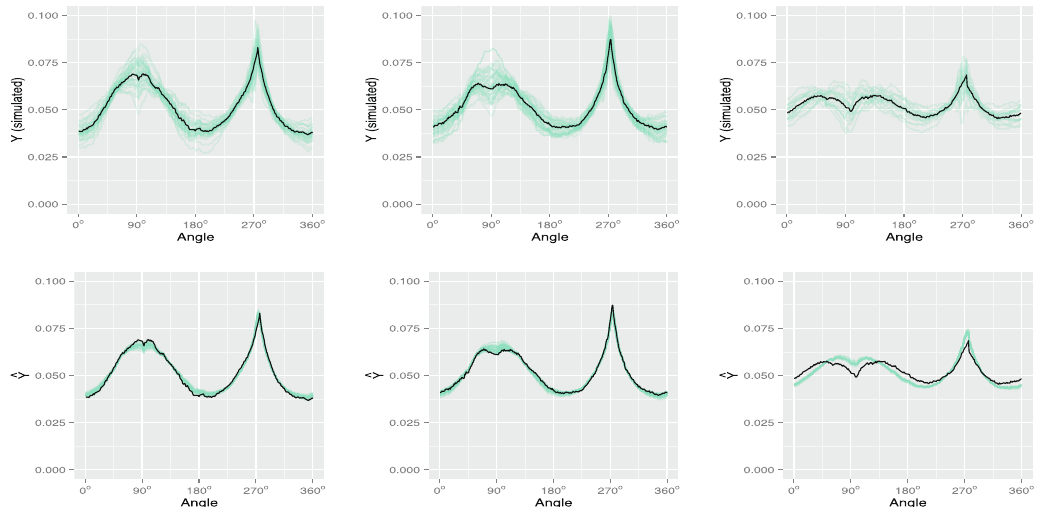
Figure 1. Visualization of the prediction performance of the FunFor approach for one replication in the Simulation 1: The top panel illustrates the simulated response samples (transparent green lines on the first row) and the bottom panel demonstrates the predicted curve response (transparent green lines on the the second row) output from the FunFor approach. Each column corresponds to a different genotype category. The black lines demonstrate the three true shapes used for generating data.